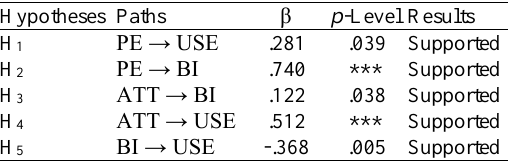
Table 4 Results of the Tests of